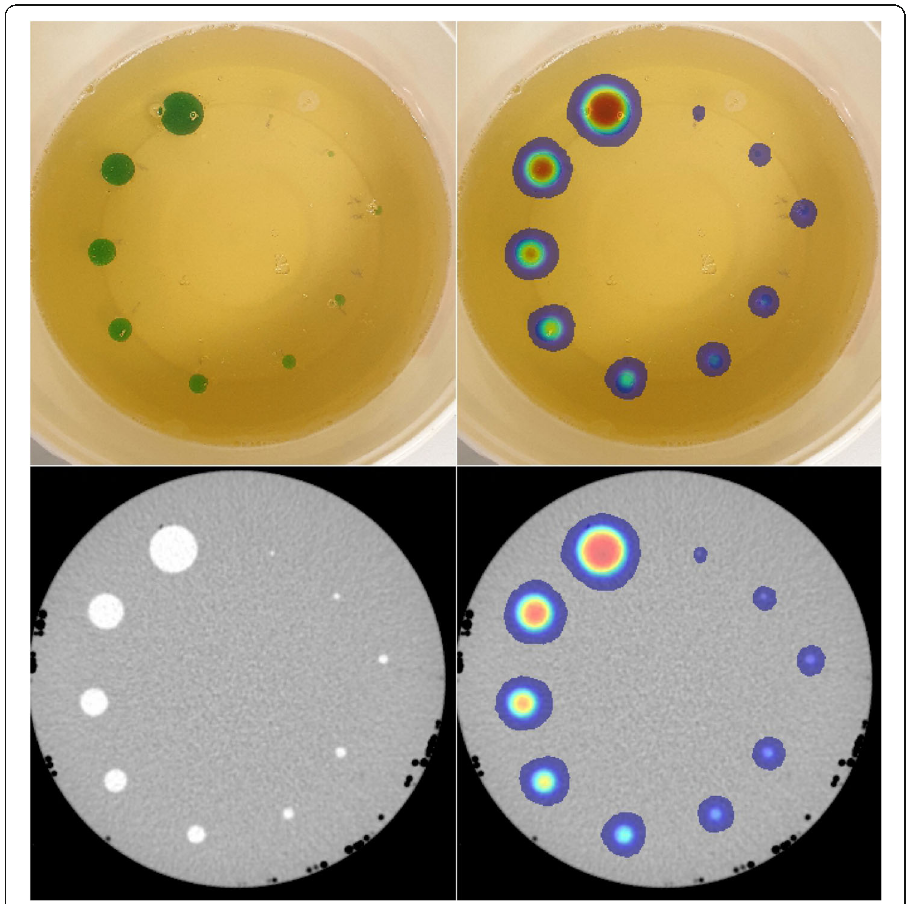
Fig. 3 Spheres in gelatin mixture ( a ), spheres in gelatin mixture with PET signal overlaid ( b ), CT of spheres ( c ) and PET/CT images of spheres ( d